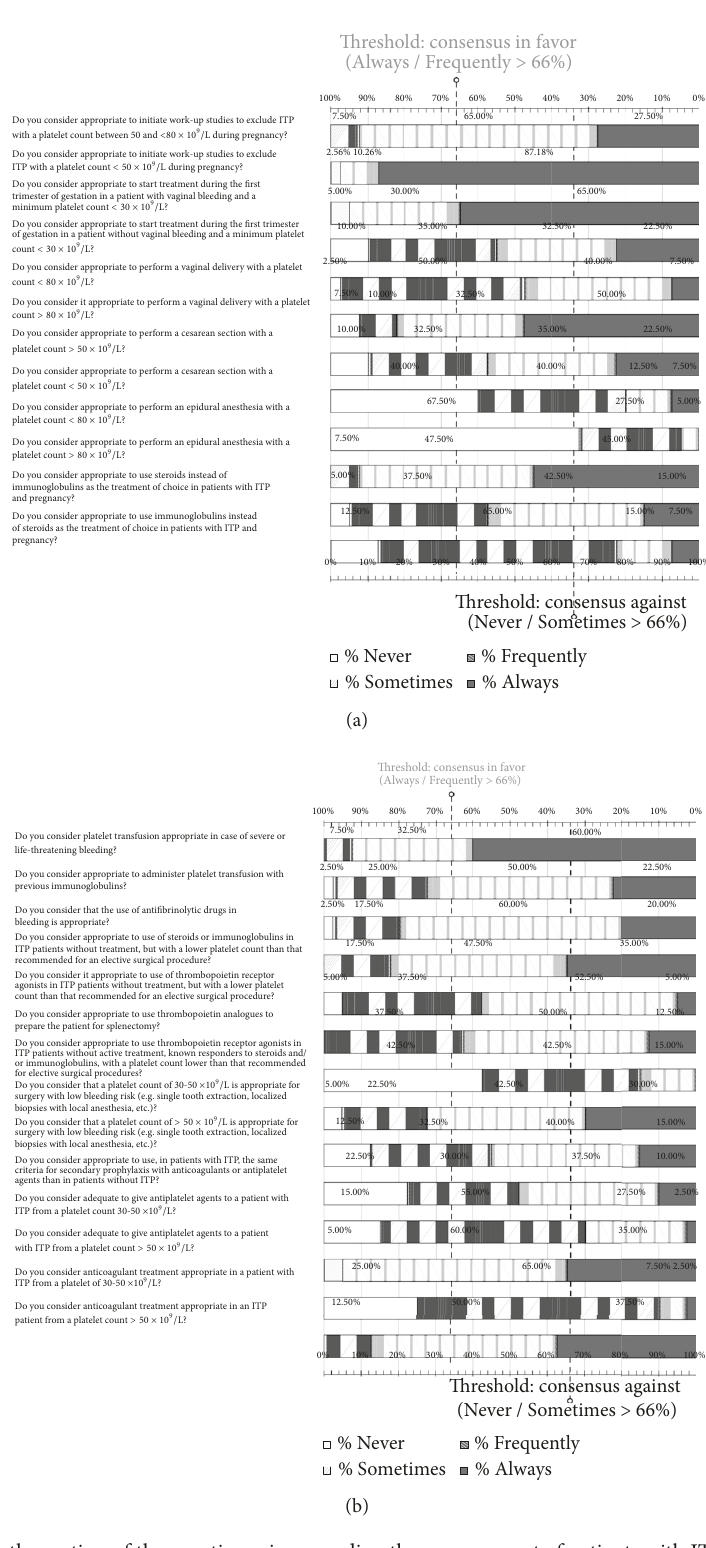
Figure 5: Results obtained in the section of the questionnaire regarding the management of patients with ITP during pregnancy (a) and in aspects related to emergencies, surgery, and safety (b). Distribution of the percentages of